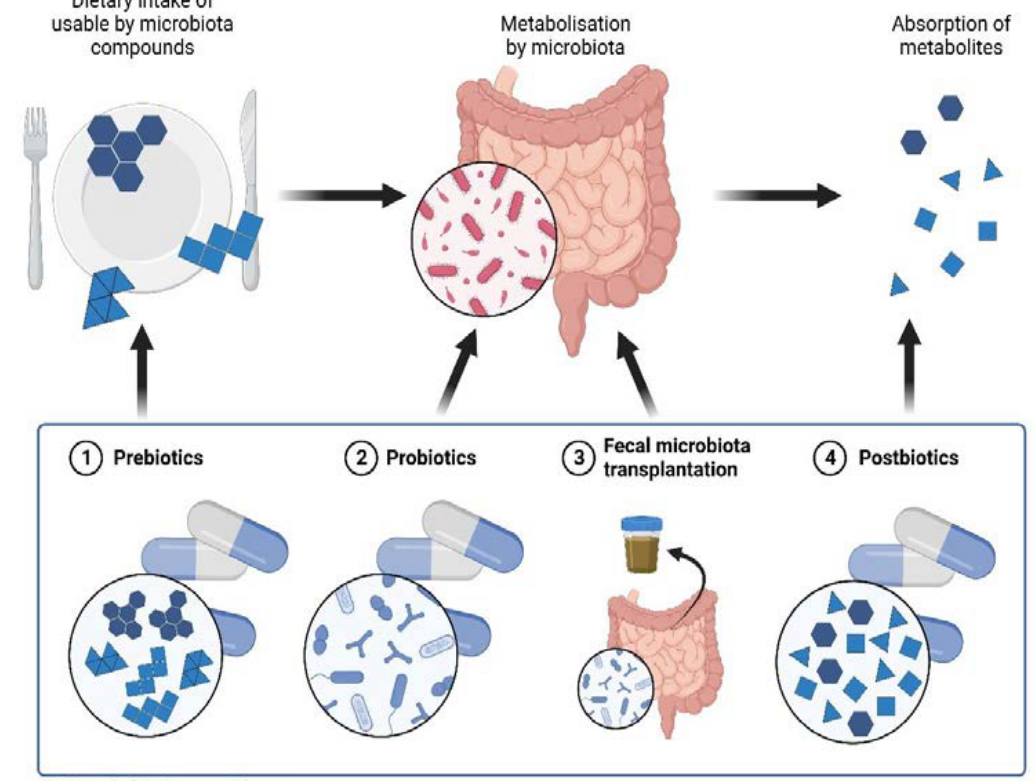
Figure 2. Production of microbiota metabolites and potential treatment options at various steps of this process. Ingested food is rich in compounds that can be utilized by intestinal microbiota. End products of microbiota metabolism are absorbed into the circulation. 1. Prebiotics, e.g., fructooligosaccharides and inulins, can be supplemented to achieve growth of beneficial microorganisms and an increase in production of eligible metabolites. 2. Probiotics. 3. Fecal microbiota transplantation is carried out with the aim to replace pathogenic bacteria with health-promoting ones. 4. Postbiotics consist of favorable metabolites of intestinal microbiota. Created with BioRender.com.